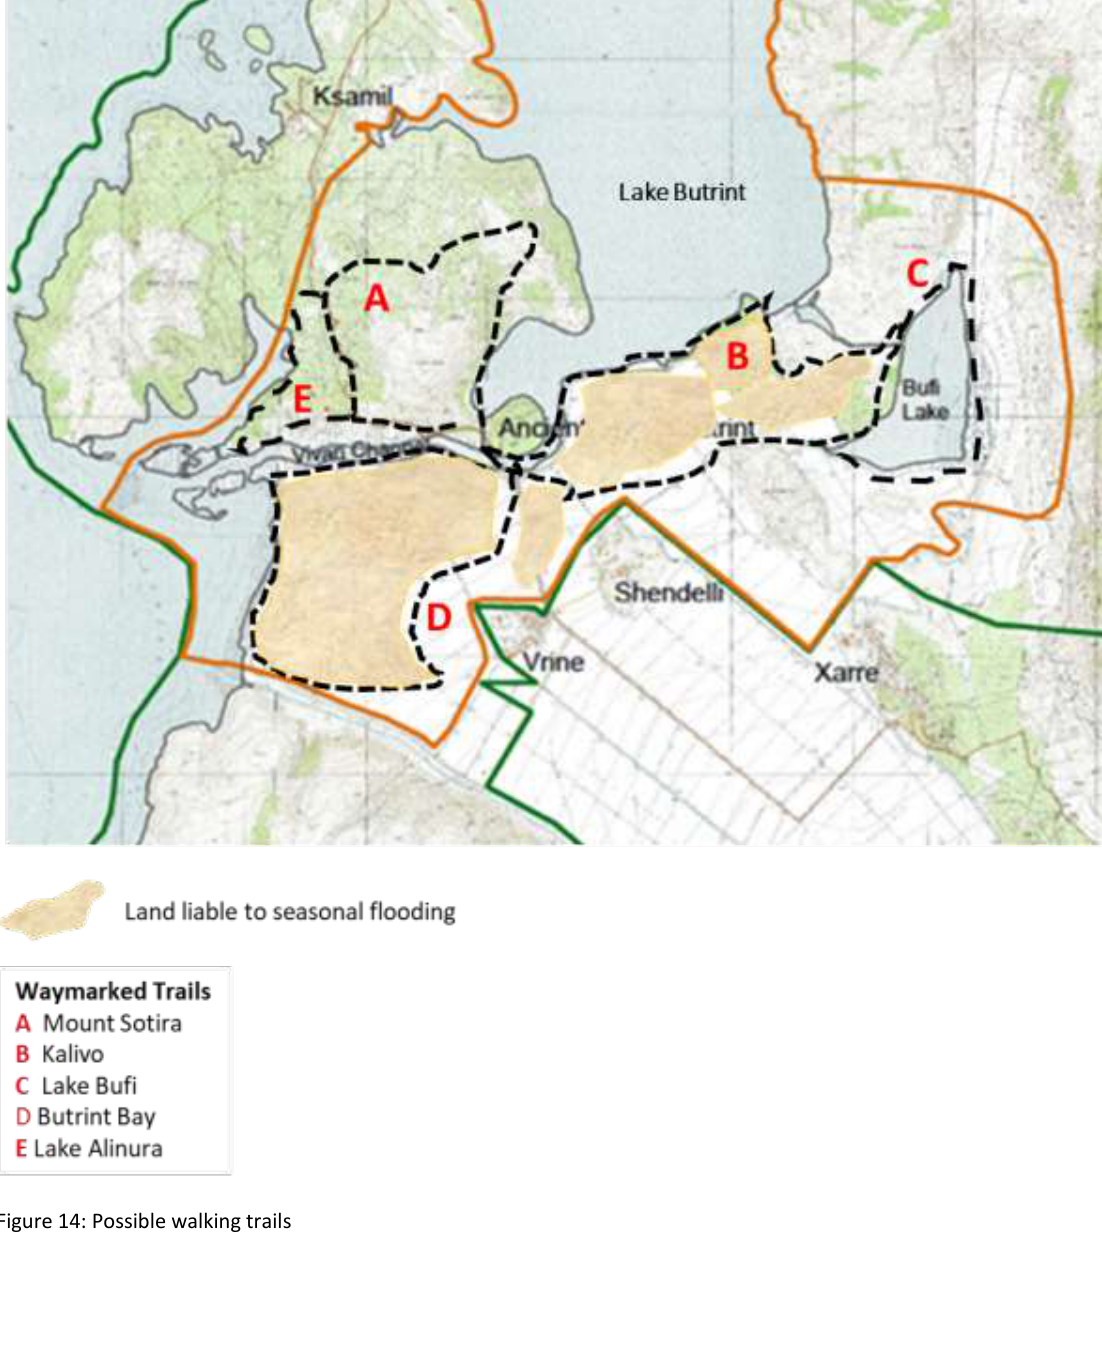
Figure 14: Possible walking